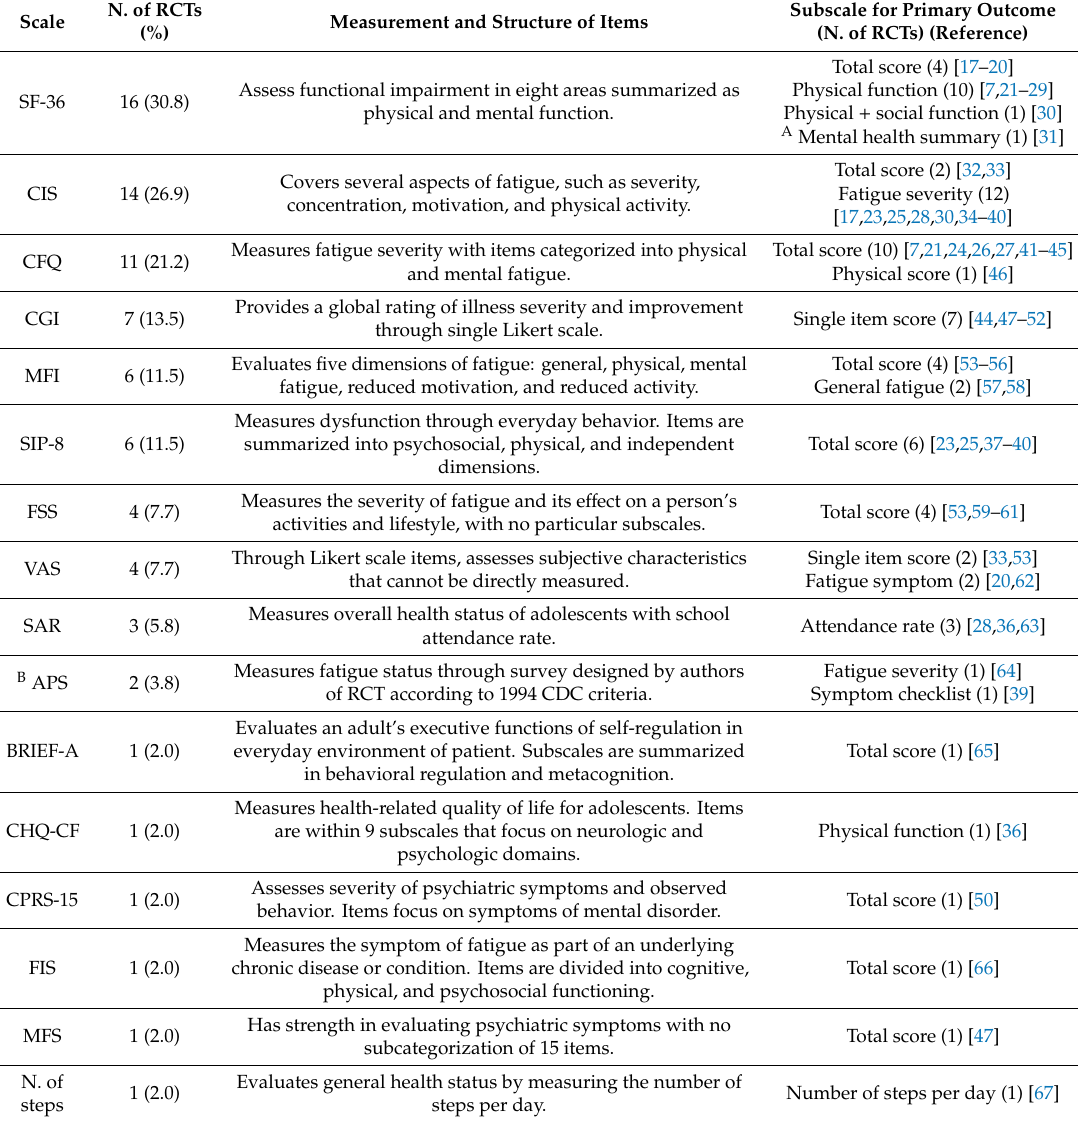
Table 2. Measurement instruments in